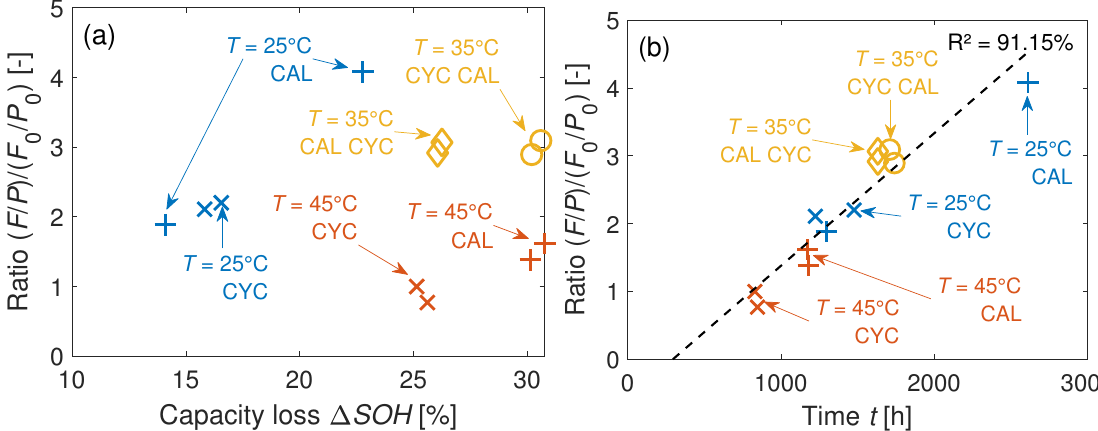
Figure 16. ( a ) Development of the F/P ratios d c FP on the GR electrodes over the capacity loss of the cell at EOL. ( b ) Respective d c FP values over the time of